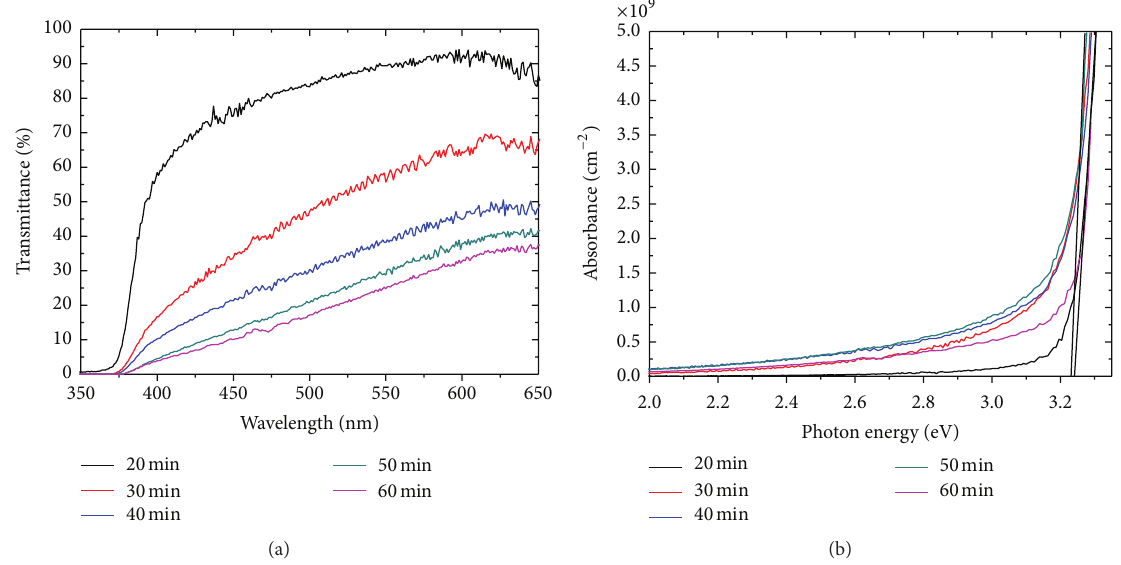
Figure 3: (a) Transmittance spectra of the ZnO:YAG films deposited for various times. (b) Relationship between the square of the absorbance and photon energy for the ZnO:YAG films.